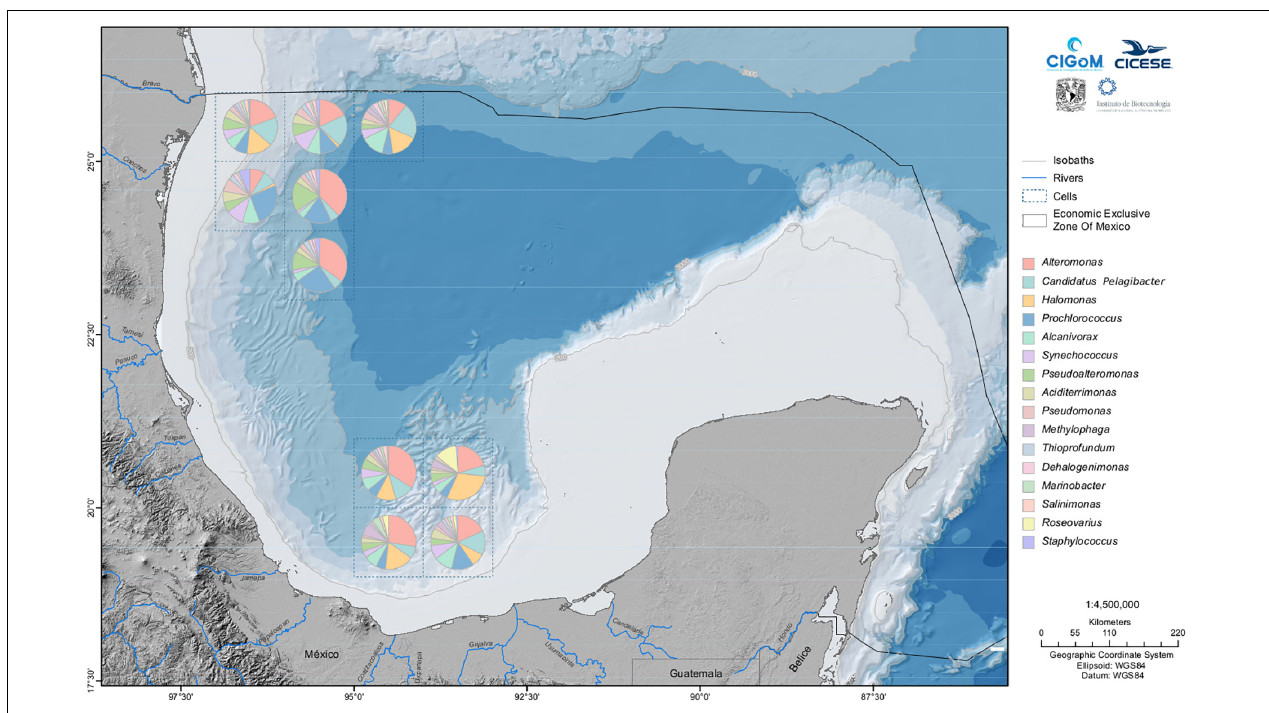
FIGURE 5 | Sixteen most abundant genera on the water column of the Gulf of Mexico. The map covers a rectangular area with the bottom right corner at 18 ◦ N, 86 ◦ W to the top left corner at 97 ◦ W, 26 ◦ N. The water column depth ranges from superficial water to 3721 m from near the